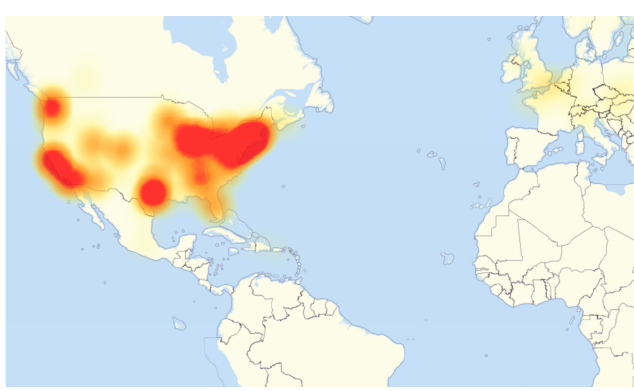
Figure 3. Map of areas most affected by attacks, 16:45 UTC,